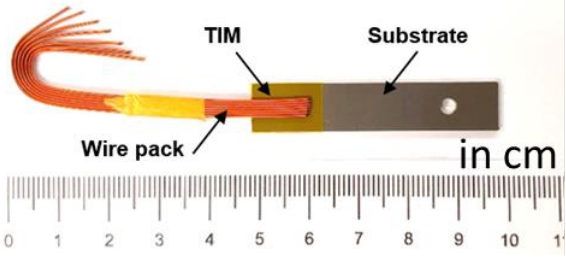
Figure 4. Wire pack adhesive bonds for a tensile shear test.